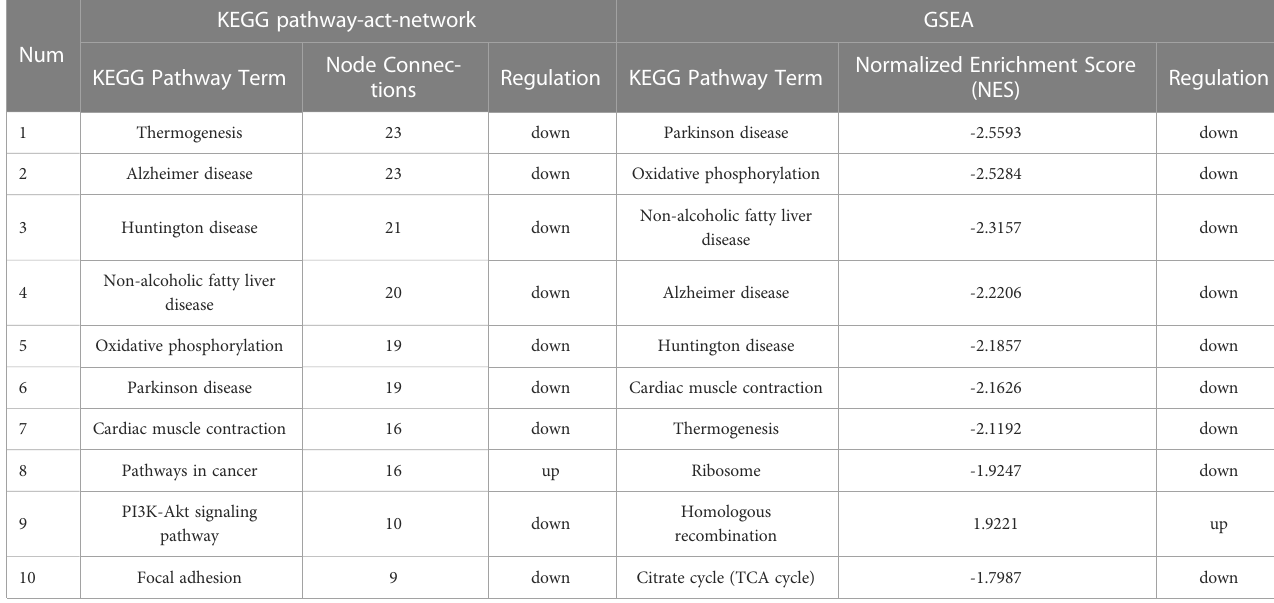
TABLE 1 The top 10 signi fi cant pathways of KEGG pathway-act-network and GSEA. KEGG pathway-act-network GSEA Num Node Connec- KEGG Pathway Term Regulation KEGG Pathway Term tions